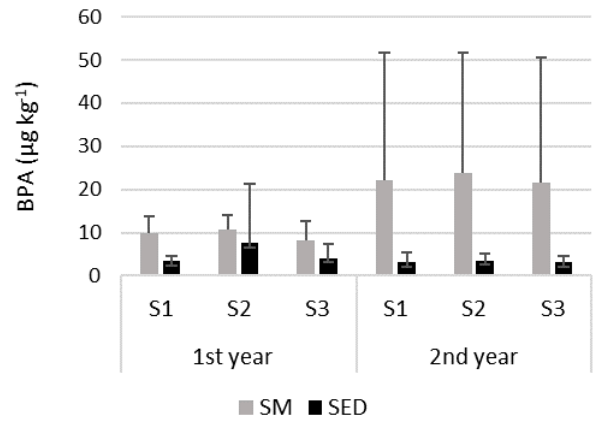
Figure 8. Annual average of the BPA concentrations for suspended matter (SM) and sediment samples (SED) collected at stations S1 to S3 in the Kaštela Bay (Adriatic Sea, Croatia) over two years (April 2015 to March 2017).